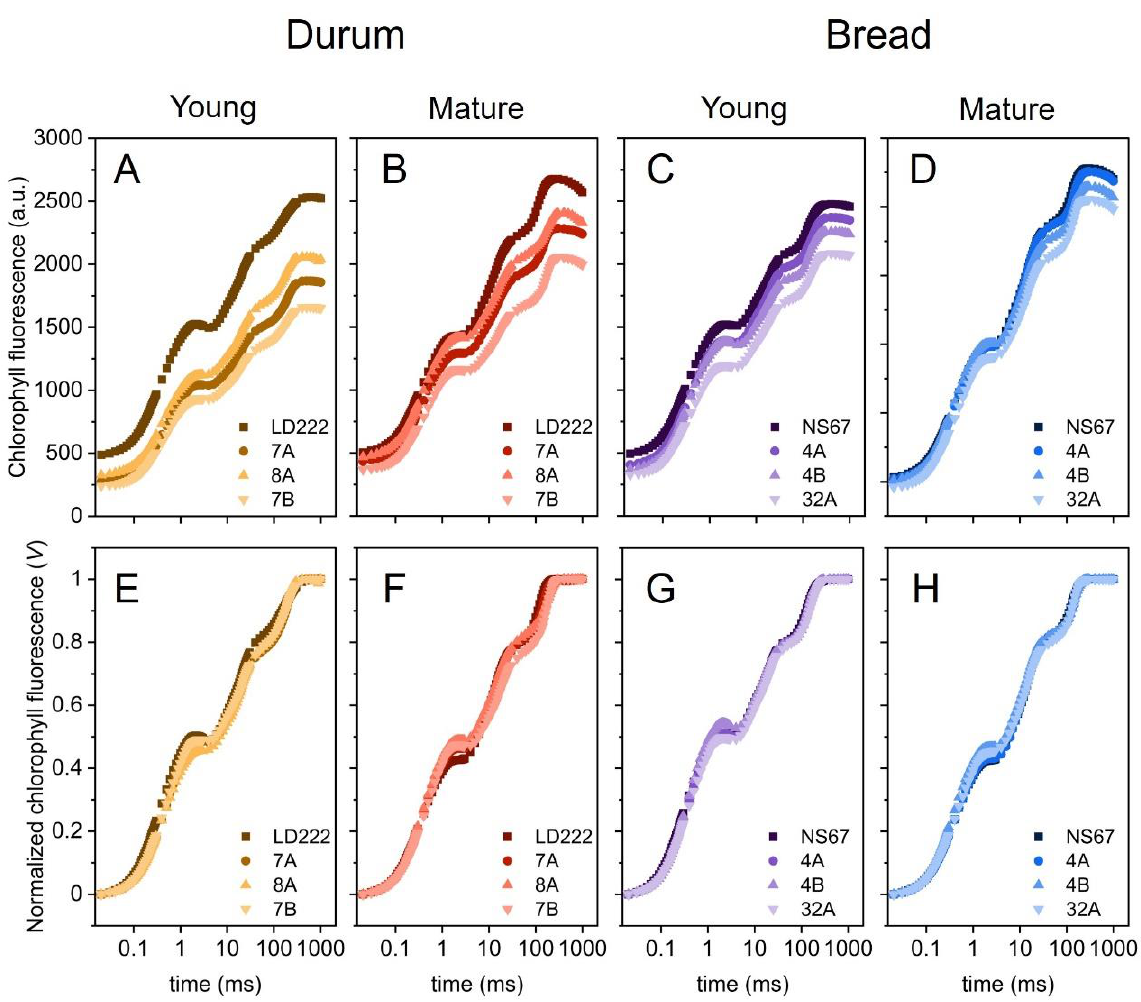
Figure 4. Fast-chlorophyll- a -fluorescence emission in young and mature plants of durum and bread wheat. ( A – D ) Average OJIP transients on logarithmic timescale. ( E – H ) Average OJIP-transient normalized between F 0 = F 20 µs and F M on logarithmic timescale.